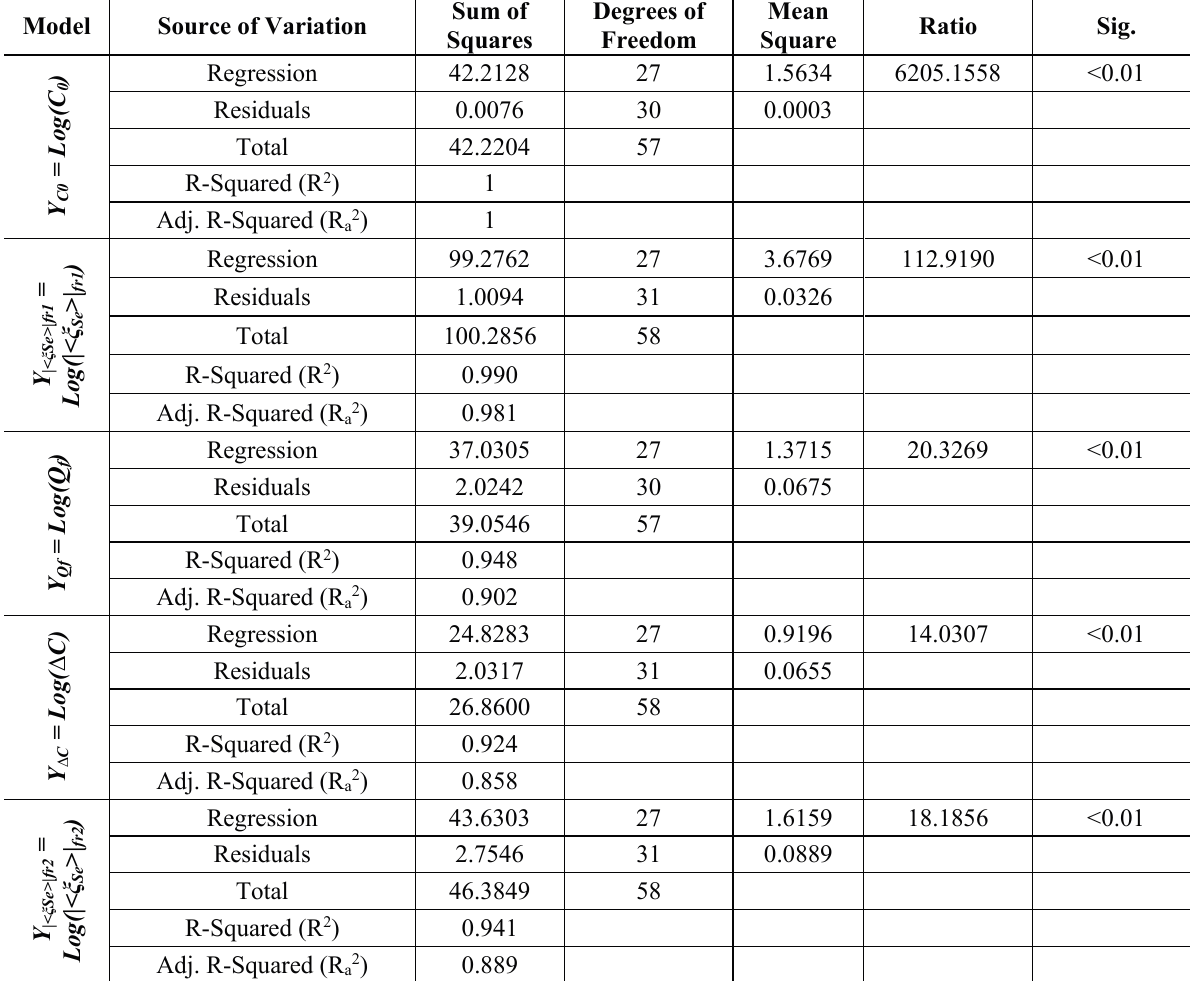
Table 5. Analysis of variance (ANOVA) table of estimated